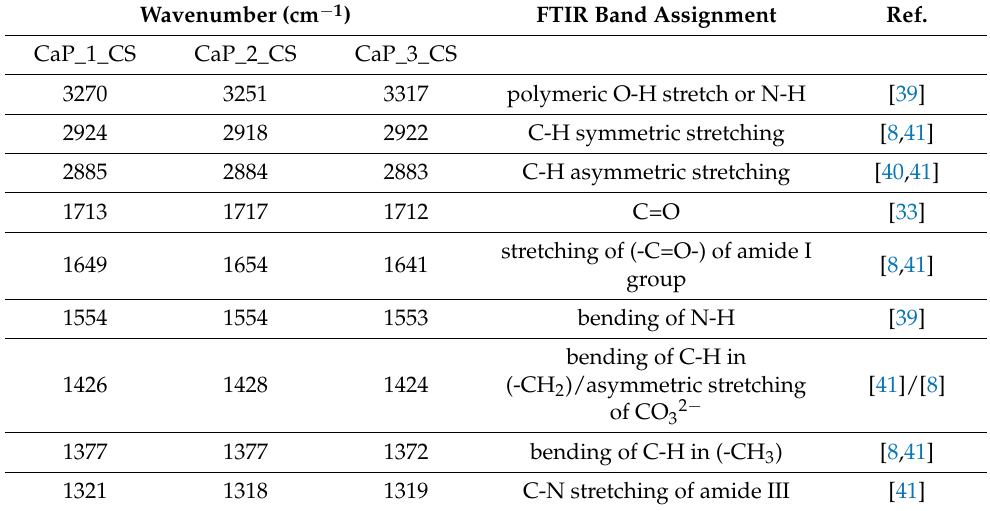
Table 4. The assignment of FTIR absorption bands for the CaP_CS coatings in the wavenumber domains: 4000–2500 cm − 1 and 1800–1200 cm − 1